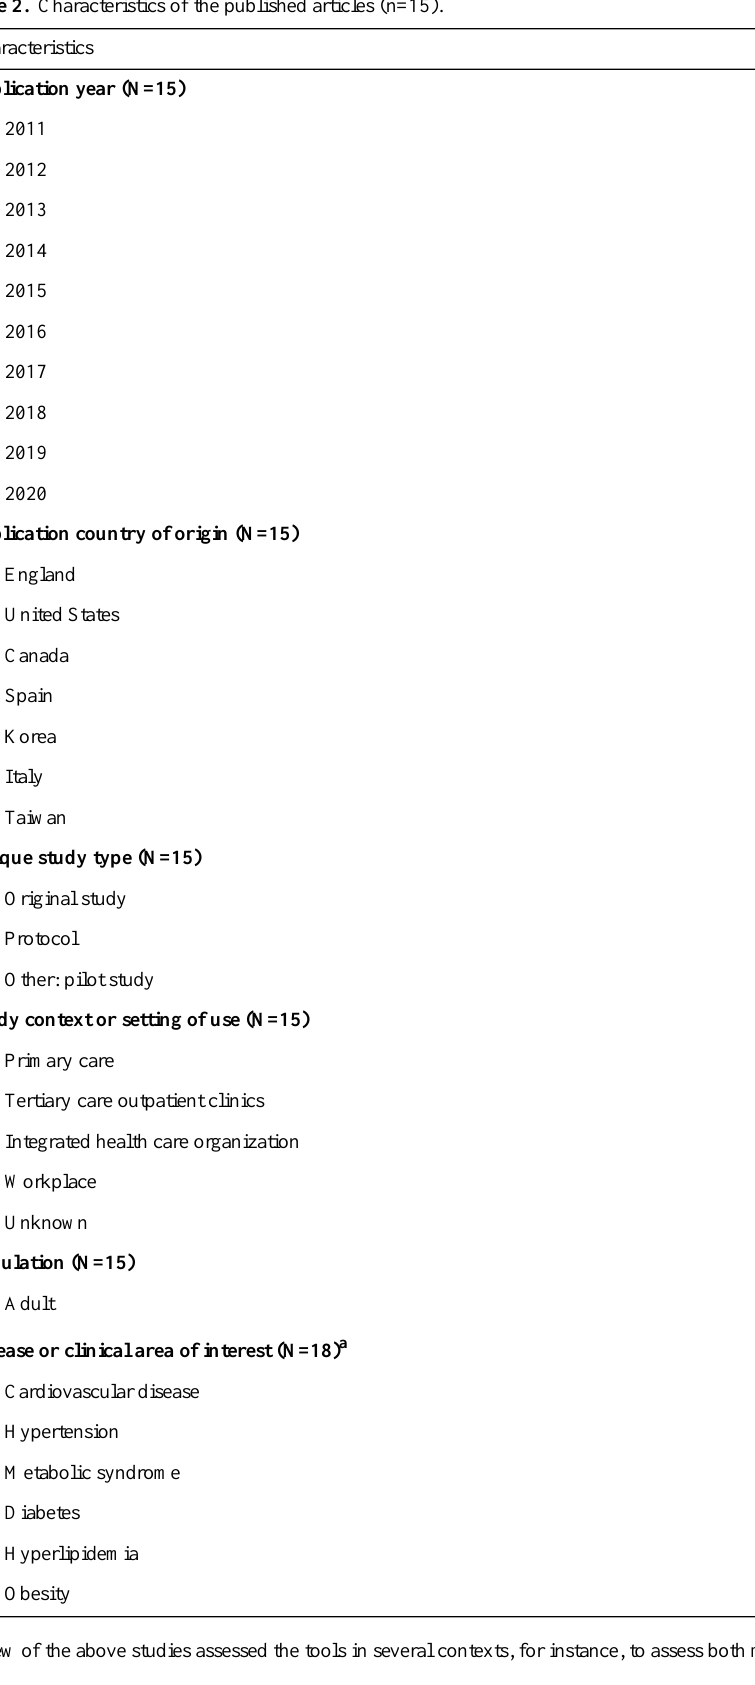
Table 2. Characteristics of the published articles